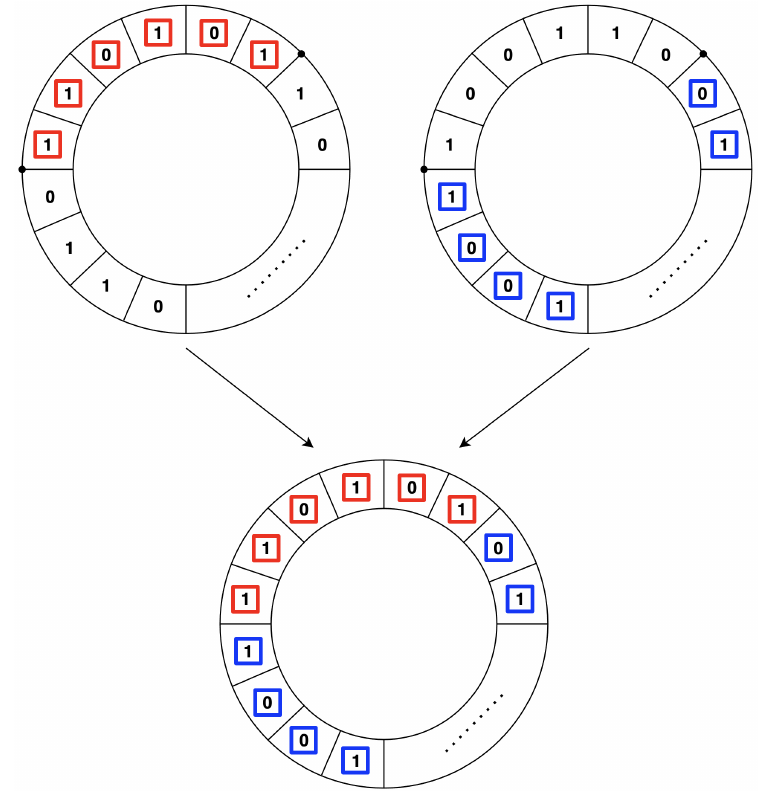
Figure 1. An example of our two-point